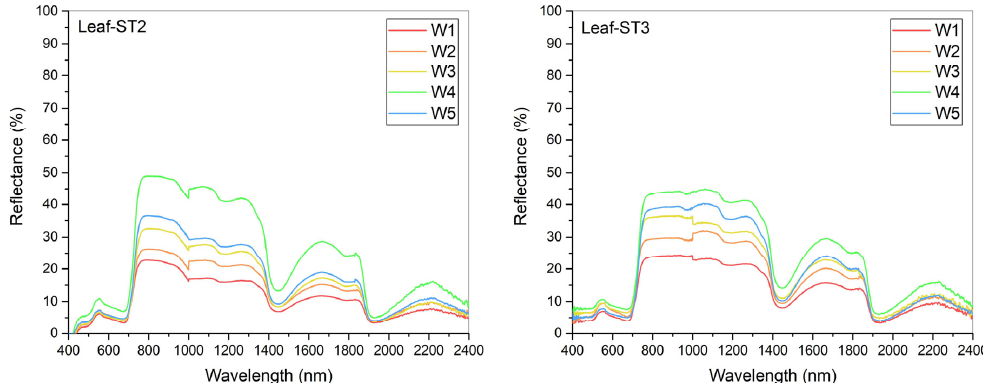
Figure 3. Leaf spectral characteristics of summer maize at the tasseling-silking stage (ST2) and maturity stage (ST3) under continuous water stresses.